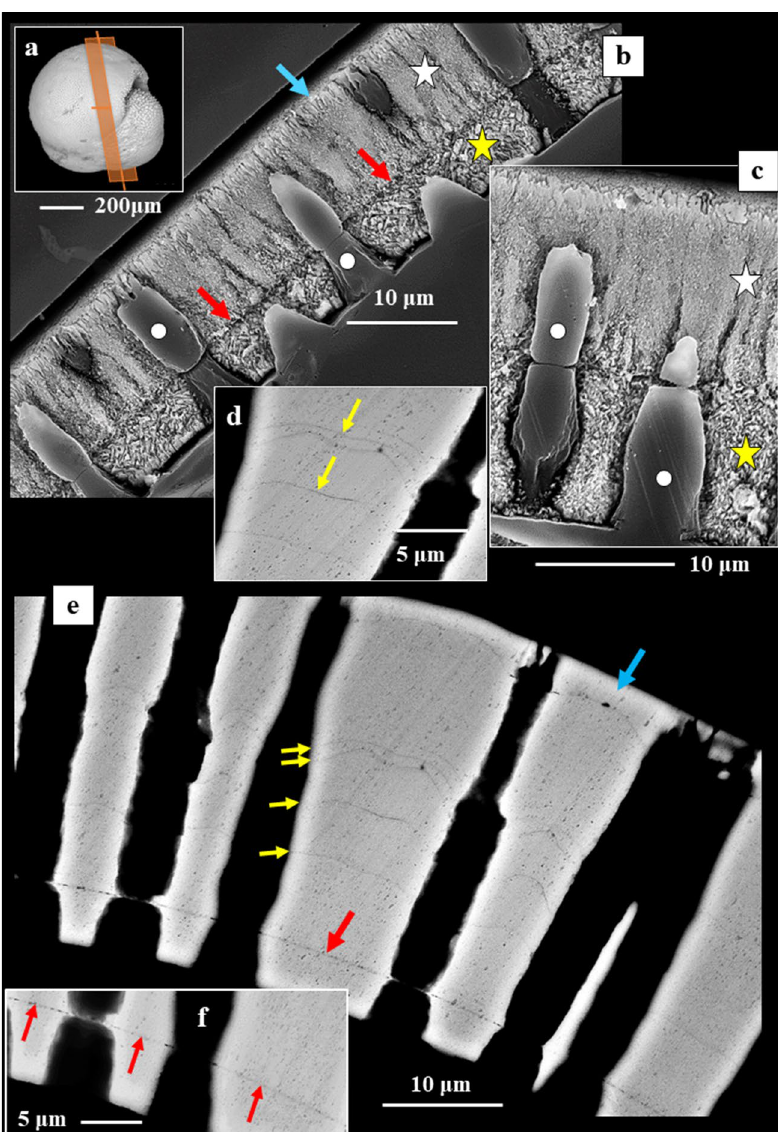
Figure 1. BSE images of shell cross-sections depicting the internal structure of Pulleniatina obliquiloculata shells. ( a ) mode of sectioning the shell. ( b , c ) BSE images of etched shell surfaces. ( d , e , f ) BSE images of highly polished, not etched, surfaces; these surfaces were used for EBSD measurements. Well visible is the subdivision of the shell wall by the primary organic sheet (POS) (red arrows in ( b , e , f )) into two layers ( b , c ). These have different microstructures (white and yellow stars in ( b ) and ( c )). White dots in ( b , c ) indicate the pores that are filled with EPON resin. The course of the POS is very evenly (e.g. ( e )) curved and predefines the curvature of the chamber. In contrast, the course of other organic incorporations (yellow arrows in ( d , e )) is wavy. The blue arrow in ( b ) and ( e ) indicates the cortex. The thickness of the latter varies slightly between 2–4 µm ( e